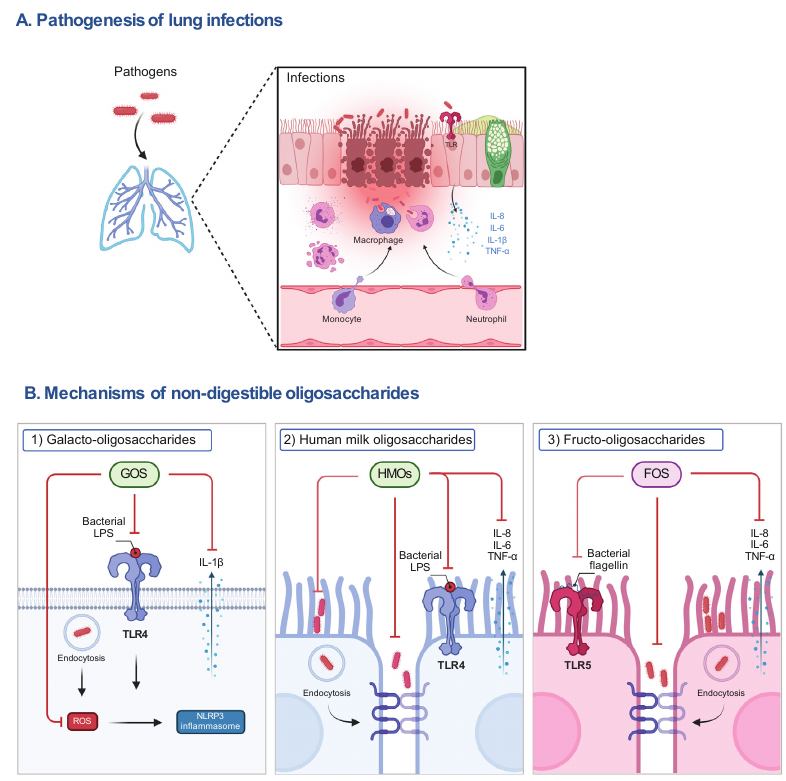
Figure 1. The pathogenesis of lung infections and the postulated mechanisms of representative NDOs on host cells. ( A ) During lung infections, pathogens can induce the release of pro- inflammatory mediators (e.g., IL-8, IL-6, IL-1 β and TNF- α ) by activating TLR signaling to recruit immune cells (e.g., neutrophils, macrophages), contributing to the phagocytosis of pathogens and elimination of inflammation in the early stage of infections. However, the impairment of the airway epithelial barrier, the accumulation of pro-inflammatory mediators, the depletion of macrophages, and the infiltration of neutrophils caused by excessive pathogens and their released virulence factors (e.g., LPS), lead to lung injury and organ dysfunction and even death of susceptible hosts. ( B ) (1) The anti-inflammatory mechanisms of NDOs (e.g., GOS) may include the inhibition of NLRP3 inflammasome activation via the interference with TLR-4 signaling and the decrease in ROS production, subsequently reducing IL-1 β release, and (2) the decrease in adhesion to and invasion of airway epithelial cells by pathogens or the direct killing of pathogens induced by NDOs (e.g., HMOs). (3) Anti-inflammatory effects of NDOs (e.g., FOS) may be related to the interference with TLR-5 pro-inflammatory signaling and protection of airway epithelial barrier function. FOS, fructo- oligosaccharides; GOS, galacto-oligosaccharides; IL, interleukin; LPS, lipopolysaccharides; NLRP3, NLR family pyrin domain containing 3; ROS, reactive oxygen species; TLR, Toll-like receptor; TNF- α , tumor necrosis factor- α .